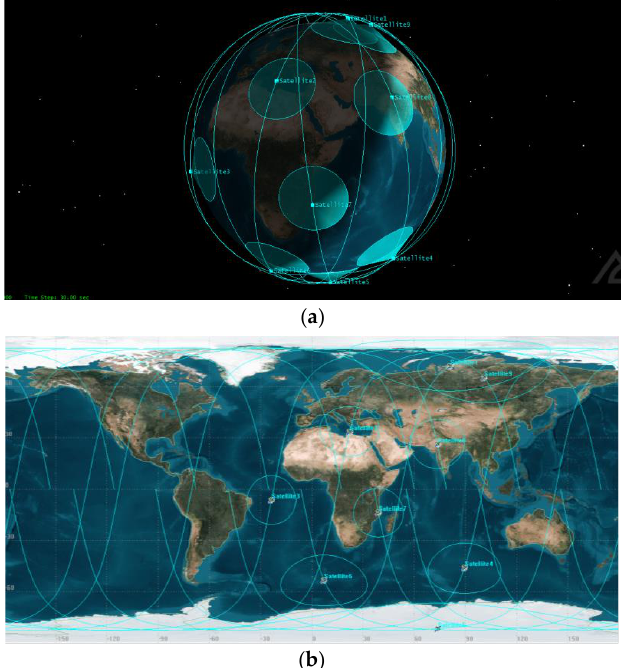
Figure 15. ( a ) Three-dimensional schematic diagram of constellation design. ( b ) Two-dimensional schematic diagram of constellation design. The received signal of star sources was simulated according to the designed occulta- tion signal receiving system, and the infrared star sources were selected within the corre- sponding apparent magnitude range under the condition that the signal-to-noise ratio was greater than 100. Figure 16 shows the coordinate distribution of all the target stars in the infrared band. As shown in the figure, the target stars are not concentrated in a certain area but are distributed throughout the entire sky area. Therefore, with an increase in the number of target star sources, not only can the global coverage of occultation events be achieved, but more data can be obtained. Figure 16. Distribution of infrared star source. 5. Conclusions In this study, the influence of orbital elements on the number, duration, and distri- bution characteristics of occultation were quantitively analyzed, a constellation design method based on infrared star sources was established and the results provided. Under the condition of 152 target star sources, not only can global coverage be achieved, but more observation events can be obtained. Under this condition, occultation events can be predicted to provide data for forward modeling and laying the foundation for further re- alization of an end-to-end simulation platform integrating event simulation, observation simulation, and data inversion. Most importantly, this provides a powerful means of achieving global environmental monitoring. Author Contributions: Conceptualization, Q.Z. and M.S.; methodology, M.S.; software, P.Z.; vali- dation, Q.Z., M.S. and X.D.; formal analysis, M.S.; investigation, P.Z.; resources, X.D.; data curation, M.S.; writing — original draft preparation, M.S.; writing — review and editing, X.D.; visualization, P.Z.; supervision, Q.Z.; project administration, Q.Z.; funding acquisition, X.D. All authors have read and agreed to the published version of the manuscript.